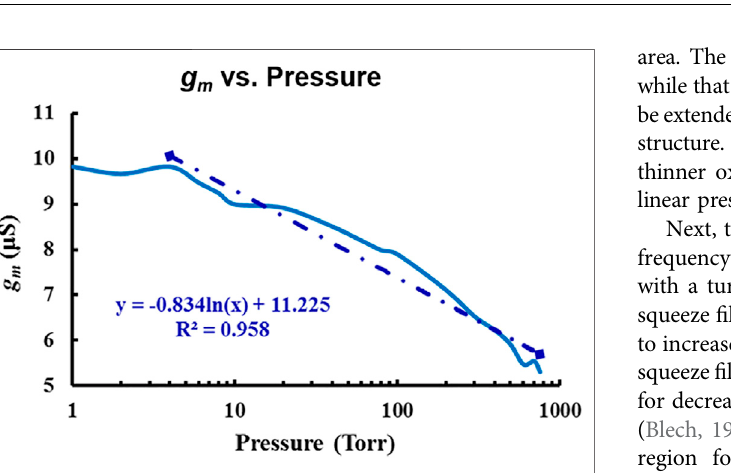
Frontiers in Mechanical Engineering |